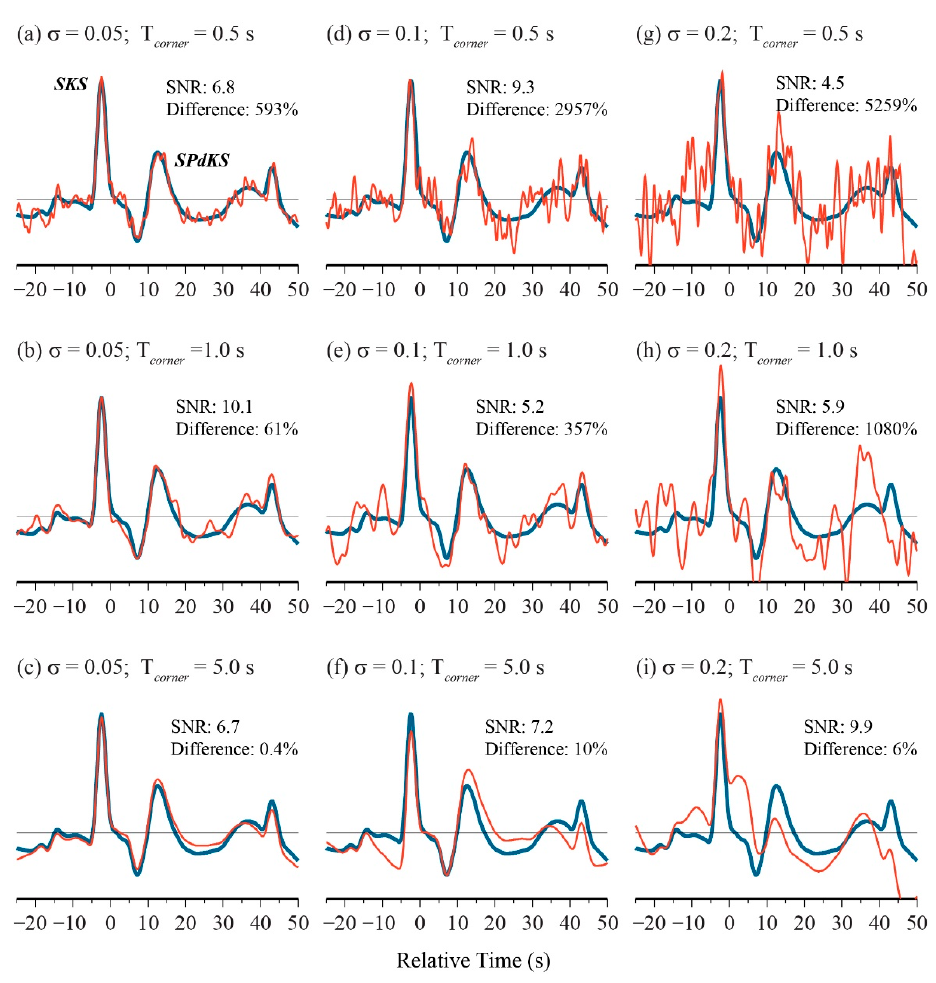
Figure 11. Sample entropy as a function of noise. Synthetic seismograms are shown for a 2.5-D ULVZ model with parameters: h = 25 km, δ V S = − 20%, δ V P = − 20%, δρ = +10%, l = 6°, and Δ edge = 13.0°. In each panel, a radial component displacement synthetic seismogram (blue) without added noise is shown for a 500 km deep event at an epicentral distance of 120°. The SKS and SPdKS arrivals are noted in panel ( a ). In each panel, the orange trace is the seismogram with added noise. Noise is added with RMS values of 0.05, 0.1, and 0.2 in each column and different corner periods of 0.5, 1.0, and 5 s in each row. In each panel, the signal-to-noise ratio (SNR) of the noisy seismogram is indicated, and the percent difference in measured sample entropy with respect to the synthetic seismogram without noise. Noise parameters for each panel are ( a ) σ = 0.05 and T corner = 0.5 s, ( b ) σ = 0.05 and T corner = 1.0 s, ( c ) σ = 0.05 and T corner = 5.0 s, ( d ) σ = 0.1 and T corner = 0.5 s, ( e ) σ = 0.1 and T corner = 1.0 s, ( f ) σ = 0.1 and T corner = 5.0 s, ( g ) σ = 0.2 and T corner = 0.5 s, ( h ) σ = 0.2 and T corner = 1.0 s, and ( i ) σ = 0.2 and T corner = 5.0 s.